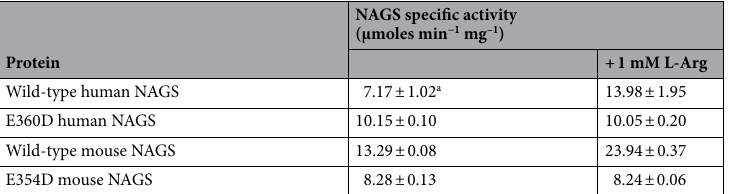
Table 2. Effect of L-arginine on enzymatic activities of either wild-type or mutant human and mouse NAGS. a Enzymatic activities are averages of three measurements and the associated standard errors.